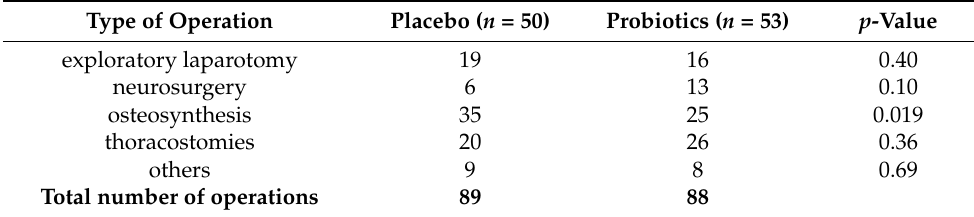
Table 2. Operations, classified according to the anatomic area per treatment group.